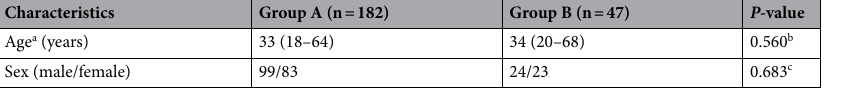
Table 1. Demographic characteristics of the participants in Experiment 1. a Median (range). b Groups were compared with the Mann–Whitney U test. c Groups were compared with the chi-square